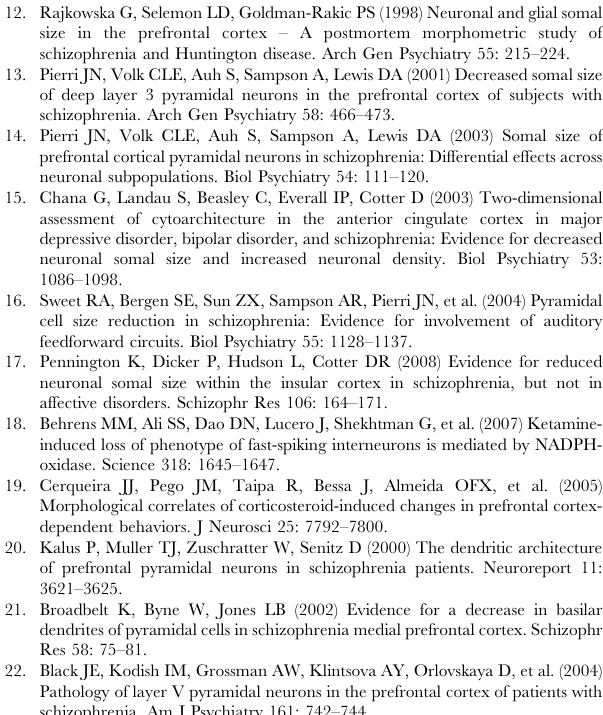
Figure S1 Gene expression levels of TNFSF13-FAS receptor pathway genes of interest relative to three